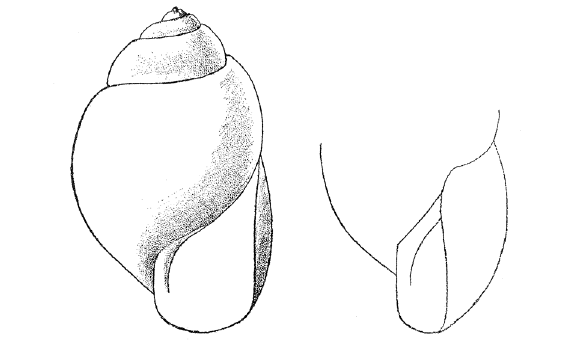
Figure 7. Original figure of Stylifer thielei Sturany,